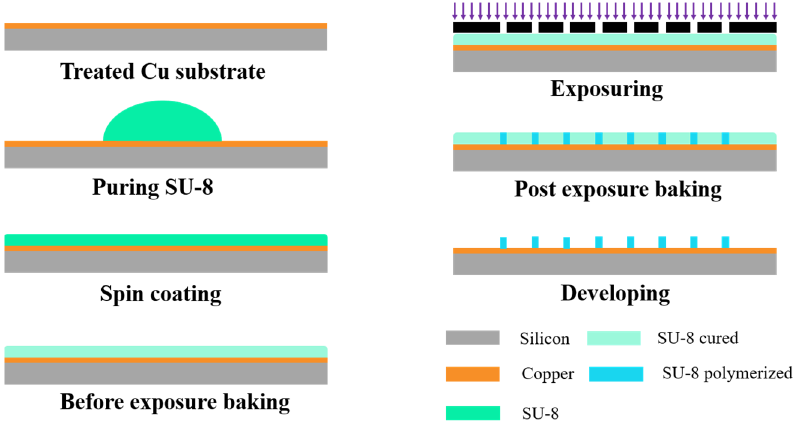
Figure 2. Processing flow diagram of SU-8 microstructure.